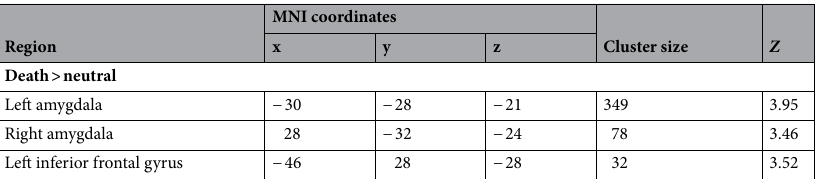
Table 1. Brain regions exhibiting significant activation during the word relationship task (death-related words vs. neutral words). p < 0.05; FDR-corrected.